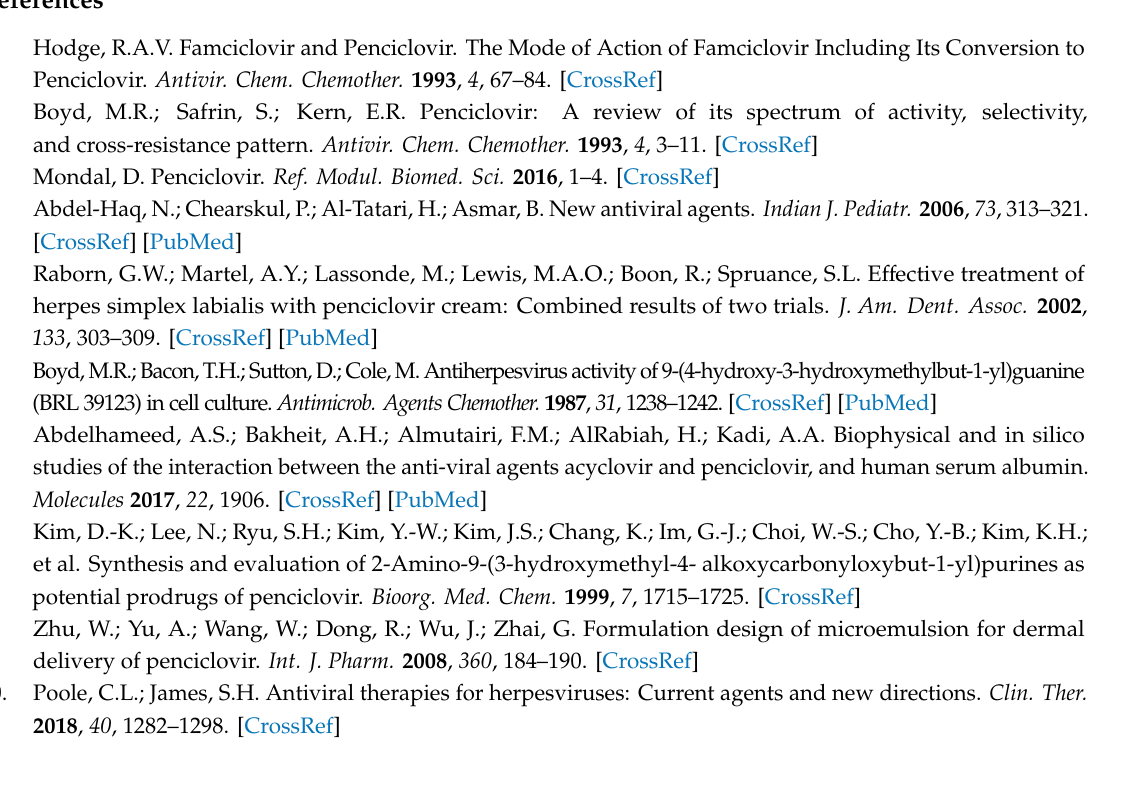
Figure S1: DSC curves of EDTA, PROPYL, METHYL, BHT, and PARAFF, Figure S2: DSC curves of LAURYL, POLAWAX, CET ALC, PROP GLY, and LIQ